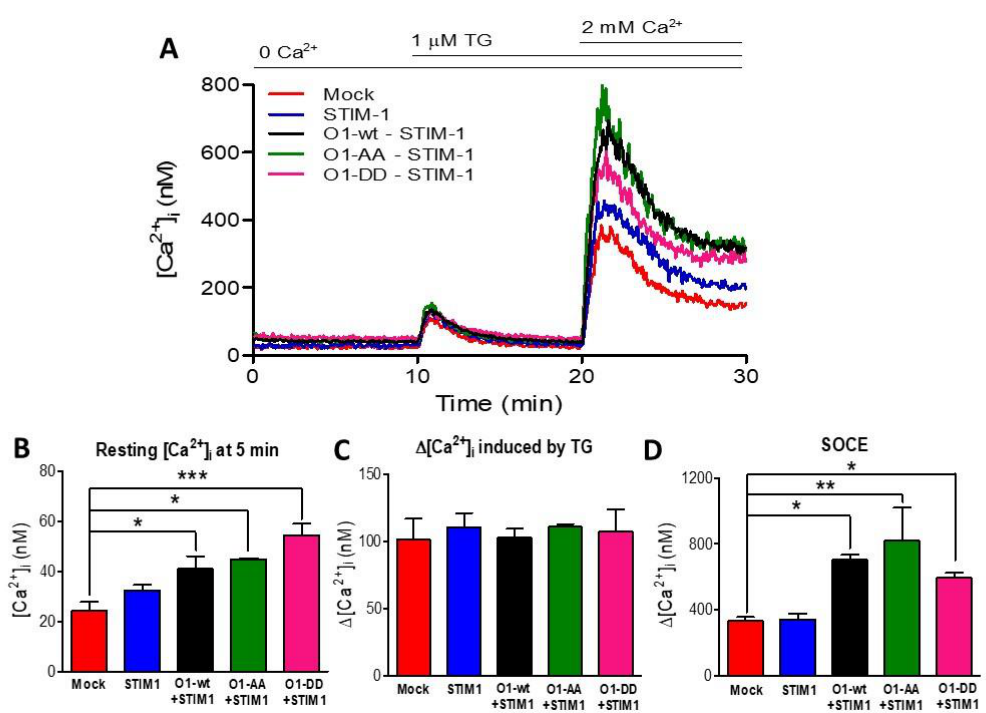
Figure 5. Cellular distribution of the different O1 channels in HeLa cells. Representative fluores- cence micrographs for cells in resting conditions expressing mCherry-O1-wt ( A ), mCherry-O1-DD mutant ( C ), or mCherry-O1-AA mutants ( E ). White bars represent 10  m. White arrows indicate the cell region used to obtain the fluorescence amplitude profile for mCherry-O1-wt ( B ), mCherry-O1- DD ( D ), or mCherry-O1-AA ( F ). Although all Orai channels displayed a certain level of internaliza- tion, the internal distribution was the largest in mCherry-O1-DD.